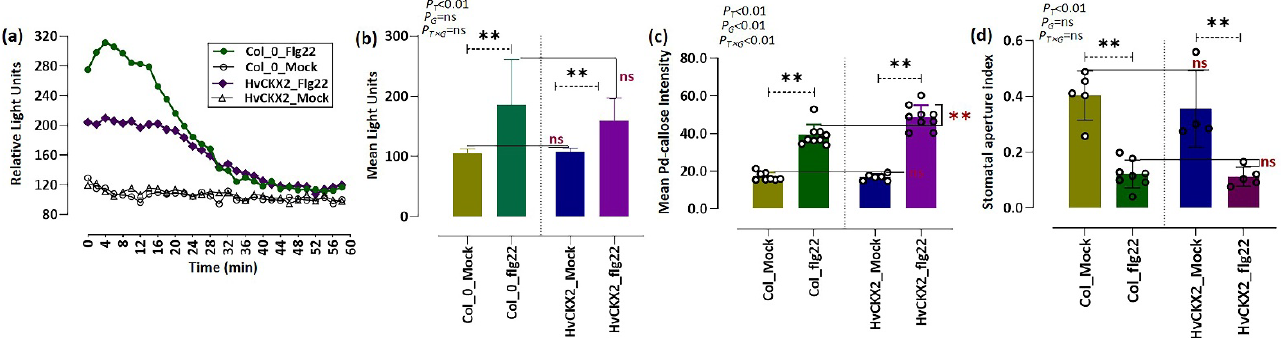
Figure 1. ( a , b ) Representative flg22-induced ROS outburst in Arabidopsis plants. The mean photon count is represented as relative light units during the first 60 min ( a ) and 24 h ( b ) after treatment with 1 µM flg22 or ddH 2 O (mock). ( c ) The intensity of flg22-triggered callose deposition in the leaves of Arabidopsis Col-0 and HvCKX2 genotypes 24 h after treatment with 1 µM flg22 or ddH 2 O (mock). ( d ) Flg22-triggered stomata closure in Arabidopsis leaves, presented as stomatal aperture index in the leaves of Arabidopsis Col-0 and HvCKX2 genotypes 24 h after treatment with 1 µM flg22 or ddH 2 O (mock). Asterisks indicate statistical differences between the indicated treatments, calculated using two-sided Student’s t -test (** significant at p < 0.001; ns, not significant). Probability value ( p ) indicates the results of two-factor ANOVA (letter ‘T’ represents treatment (Flg22 and Mock); letter ‘G’ represents genotype ( HvCKX2 and Col_0); ‘T × G’ represents interaction between genotype and treatment).